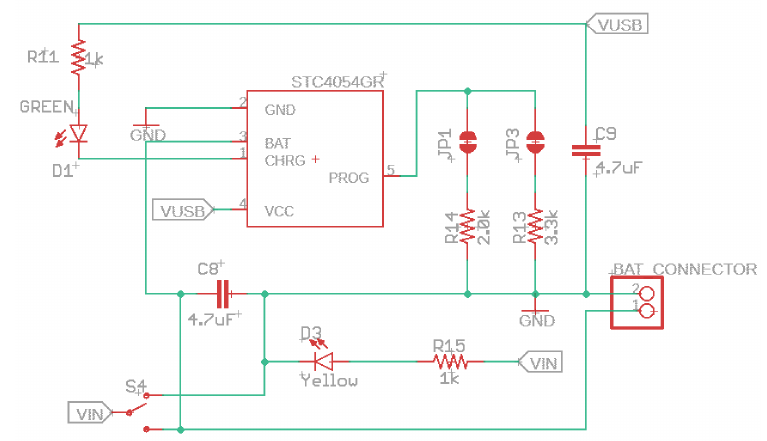
Figure 3. Built-in linear battery charger current up to 800 mA